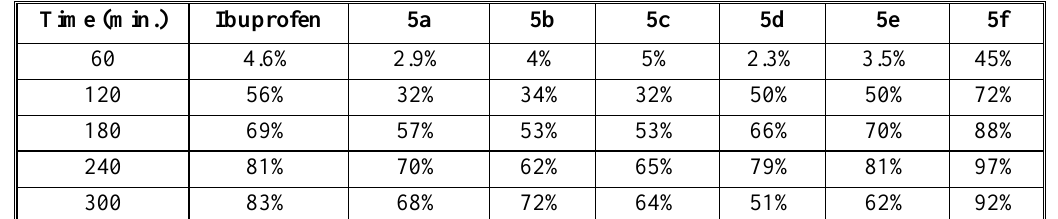
Table (4 )Percent of inhibition of inflammation for ibuprofen and compounds 5a ‐ f on egg ‐ white induced paw oedema in